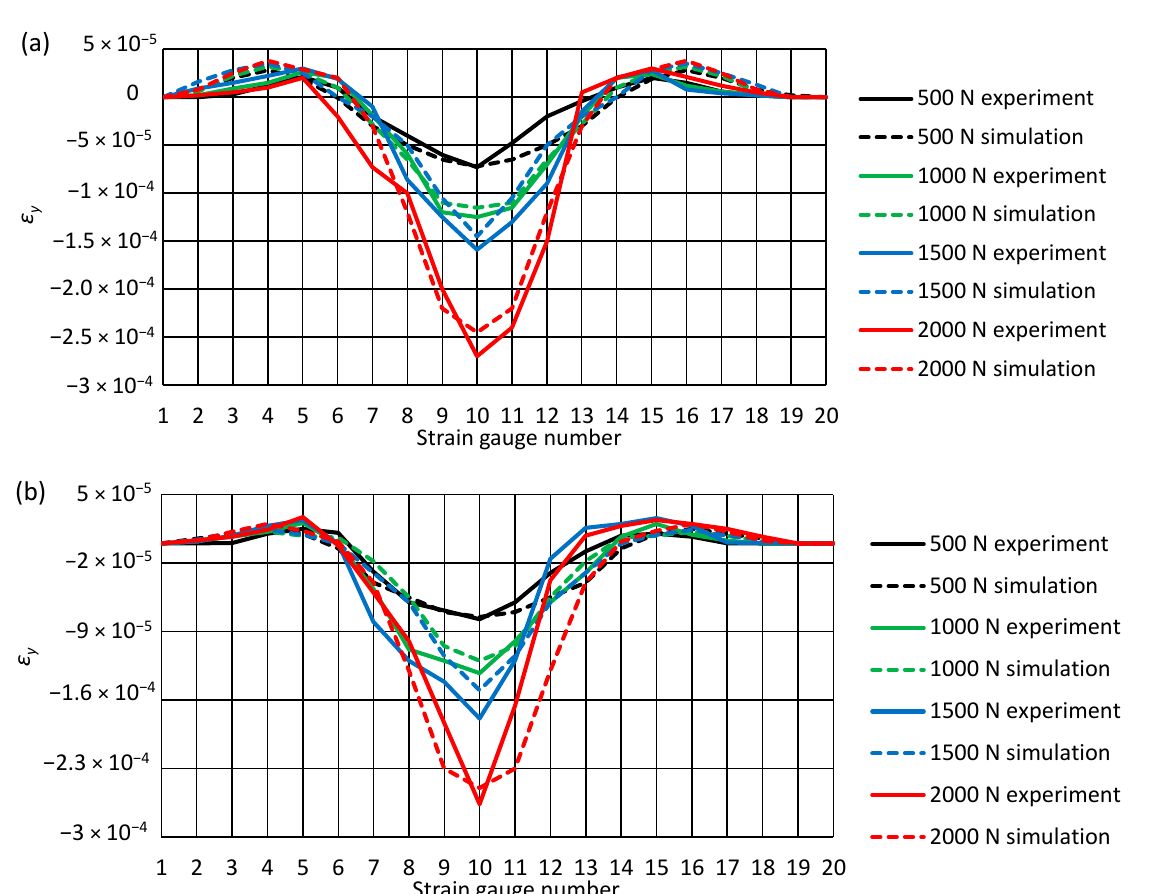
Figure 11. Transverse deformations of the pipe ε y at different external loads: ( a ) top of the pipe, ( b ) bottom of the pipe.